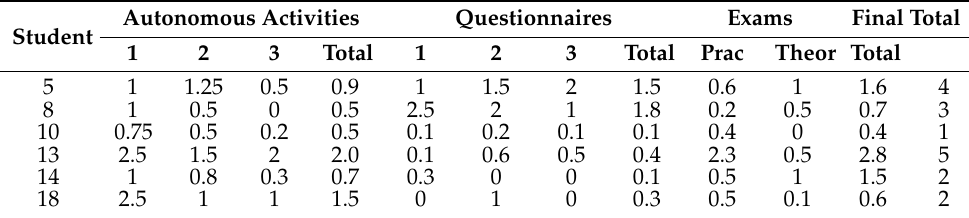
Table 3. Detail of the performance of the students in each activity during the class period.